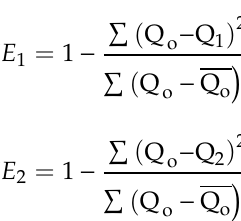
Figure 4. Land use of the Misai basin.